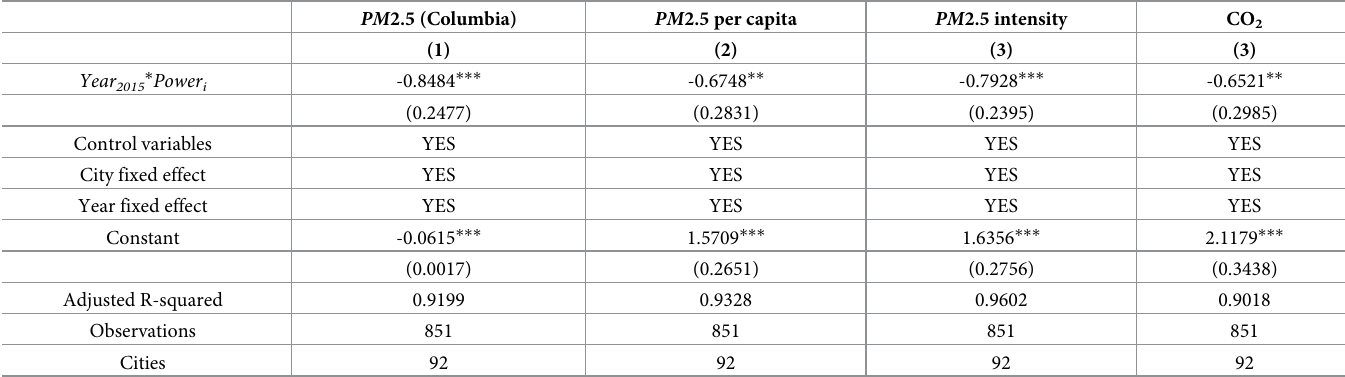
Table 5. Replacement dependent variables.